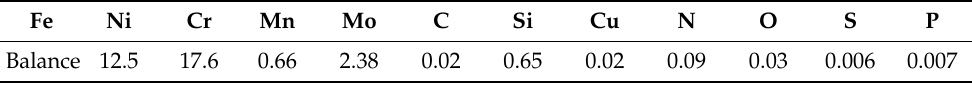
Table 1. Chemical composition of the 316L powder in wt% utilized in this